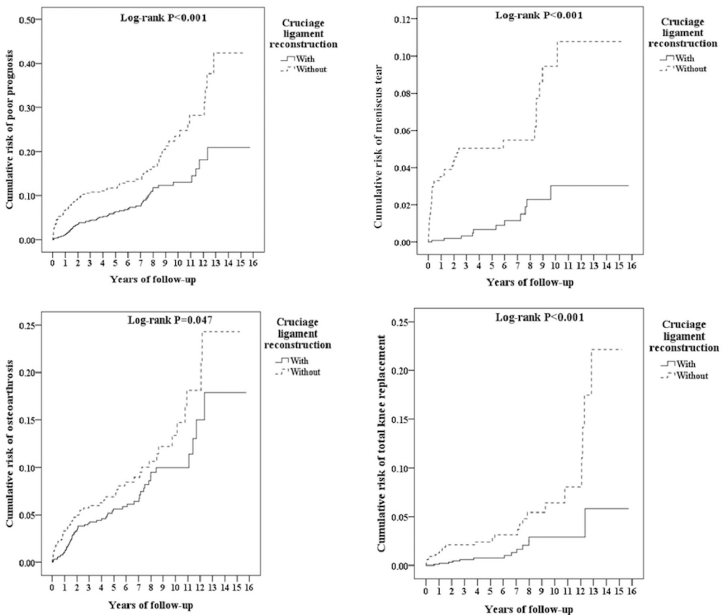
Fig 2. Kaplan-Meier for cumulative risk of poor prognosis among posterior cruciate ligament of knee aged 18 and over stratified by cruciate ligament reconstruction with log-rank test. Left-top: Total poor prognosis. Right-top: Meniscus tear. Left-button: Osteoarthrosis. Right-button: Total knee replacement.